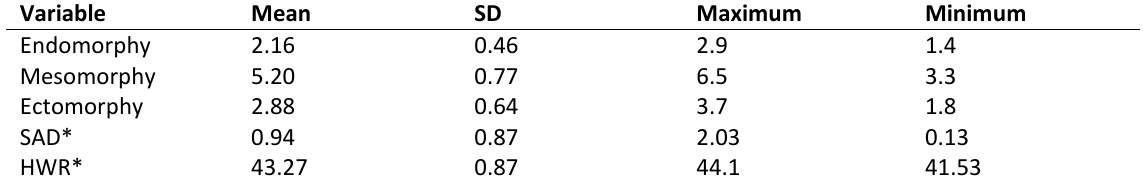
Table 2. Somatotype variables of young elite wrestlers